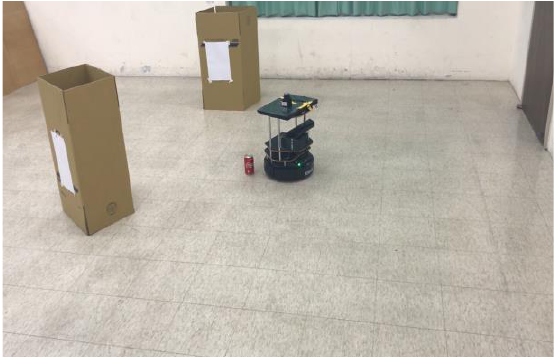
Figure 21. Third-person view of mobile robot reaching the target object in the second arena.